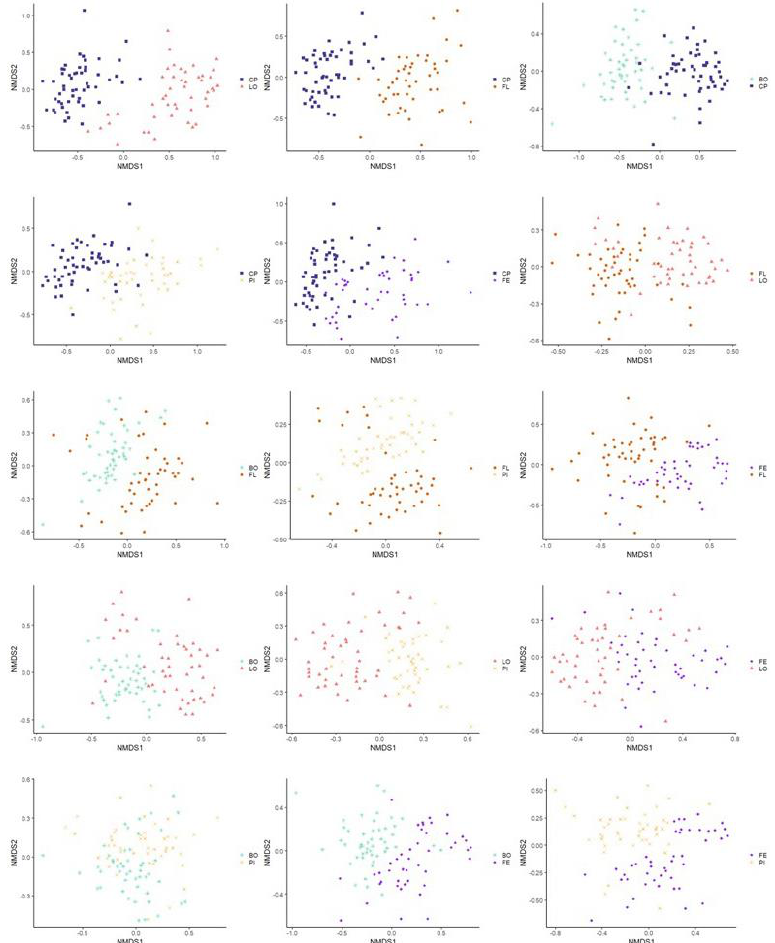
Figure 4. Non-Metric Multidimensional Scaling Graphs (NMDS) using Bray–Curtis index illustrating sample microbiome beta-diversity according to production line and paired two by two. Turquoise star: Boston production line (BO); Blue square: Main production line (CP); Purple diamond: Ham production line (FE); Orange circle: Belly production line (FL); Pink triangle: Loin production line (LO); Yellow x: Picnic production line (PI).